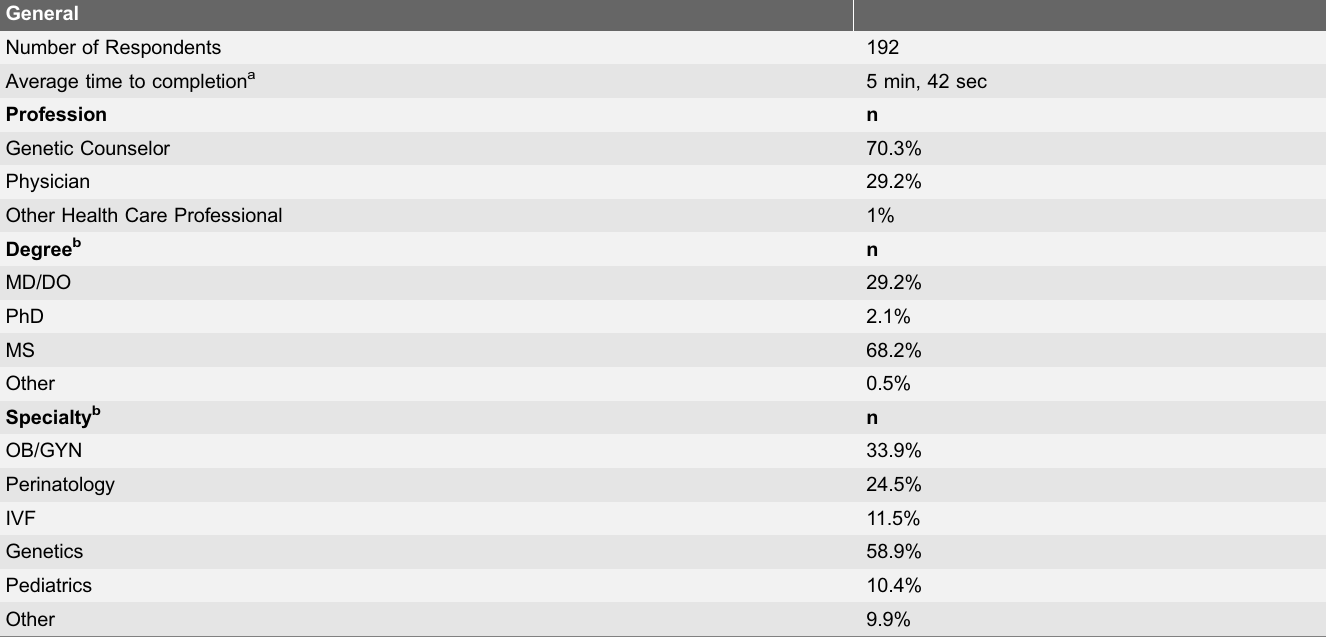
Table 4. Demographics of survey